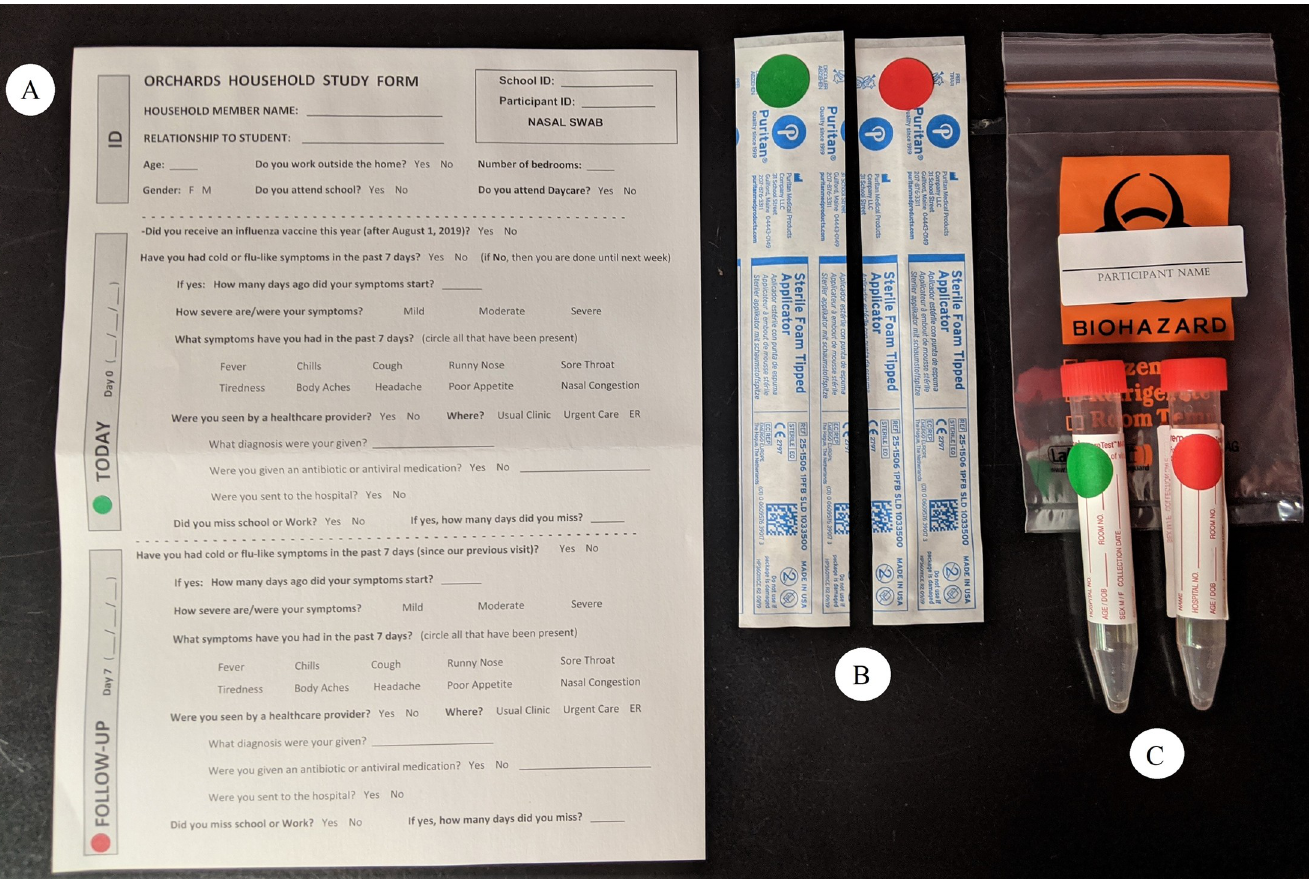
Fig 2. Deconstructed Household Substudy Kit. Each household participant receives a (A) Household Substudy questionnaire, (B) two midturbinate or anterior nasal swabs color coded to represent Day 0 and Day 7 (anterior nasal shown), (C) two VTMs color coded to represent Day 0 and Day 7, and a biohazard bag to place the collected specimens